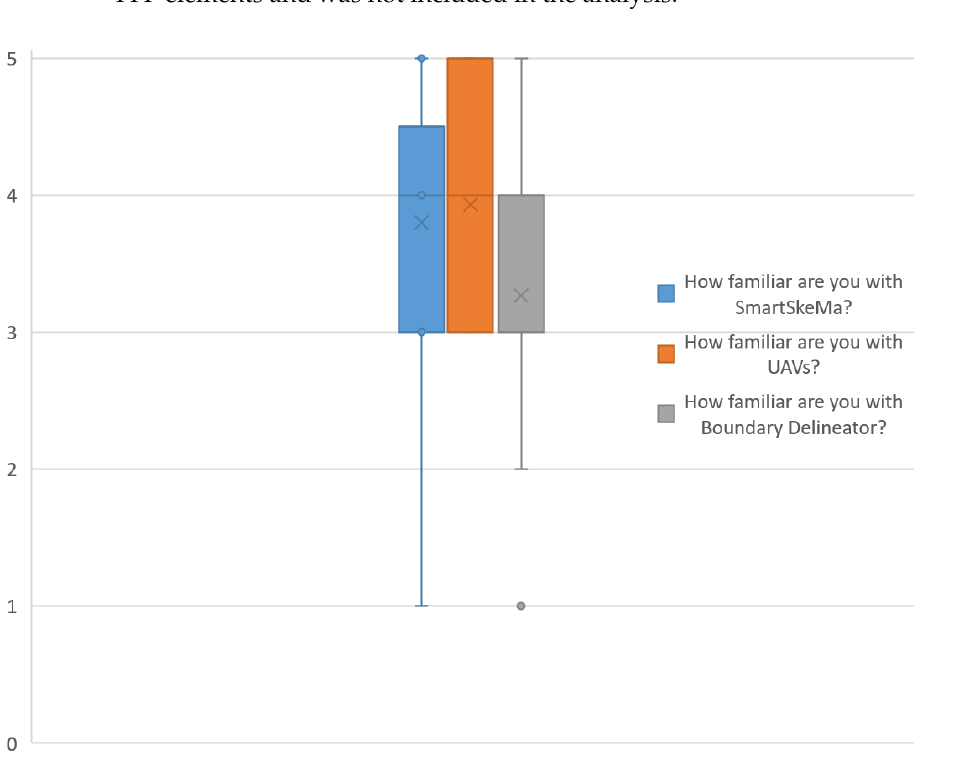
Figure 8. Familiarity of the participants with the tools and the platform.